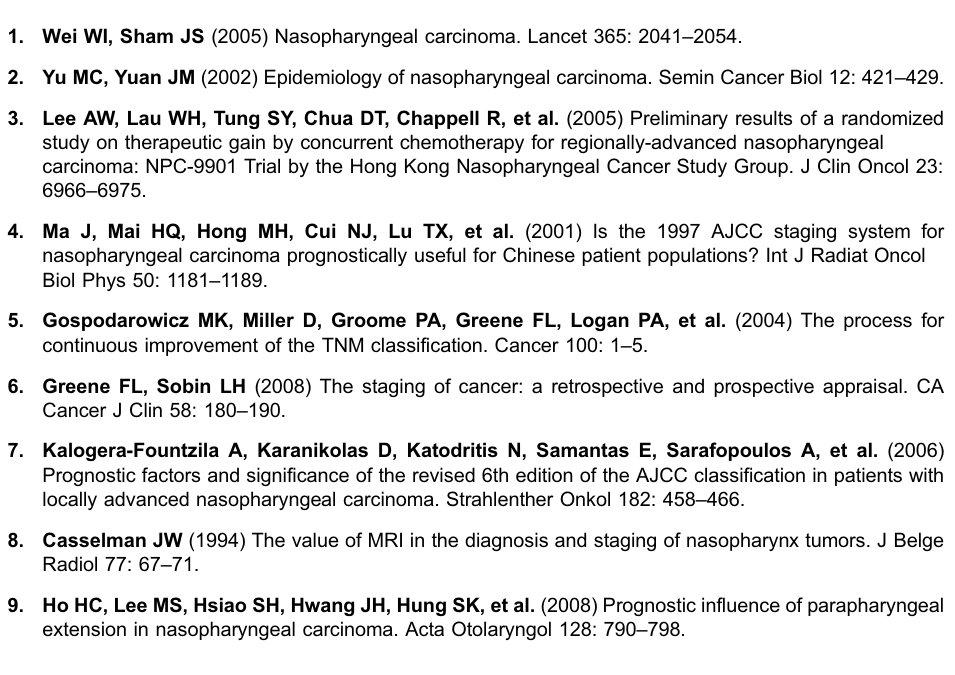
S1 Table. Baseline clinical characteristics of the 2,671 nasopharyngeal carcinoma patients. S2 Table. Comparison of the survival rate by TNM 6th and TNM 7th staging system. S3 Table. Multivariate analysis of independent prognostic factors in NPC